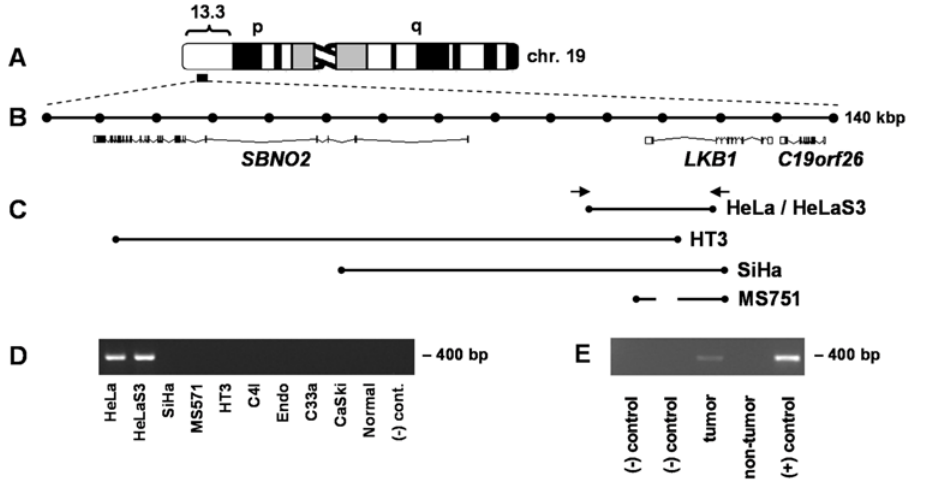
Figure 4. LKB1 deletion breakpoints in cervical cancer cell lines. (A) LKB1 locus (chromosome 19p13.3). (B) 140 kb region (Ensembl50; 1050000–1190000) spanning LKB1 and immediately flanking loci; intervals=10 kb. (C) Deletion breakpoints for cell lines harboring homozygous deletions. In MS751, deleted sequences are discontinuous as shown, consistent with a more complex rearrangement. Arrows=PCR primers for HeLa specific PCR (400 bp). (D) HeLa specific PCR (400 bp) confirms presence of deletion in HeLaS3. (E) HeLa intragenic LKB1 deletion occurred in vivo . Archival blocks were cored for DNA preparation. Lanes are as follows: ( 2 ) control=no template control; tumor=metastatic adrenal deposit; non- tumor=normal adrenal (same tissue block); ( + ) control=HeLa cell line DNA.